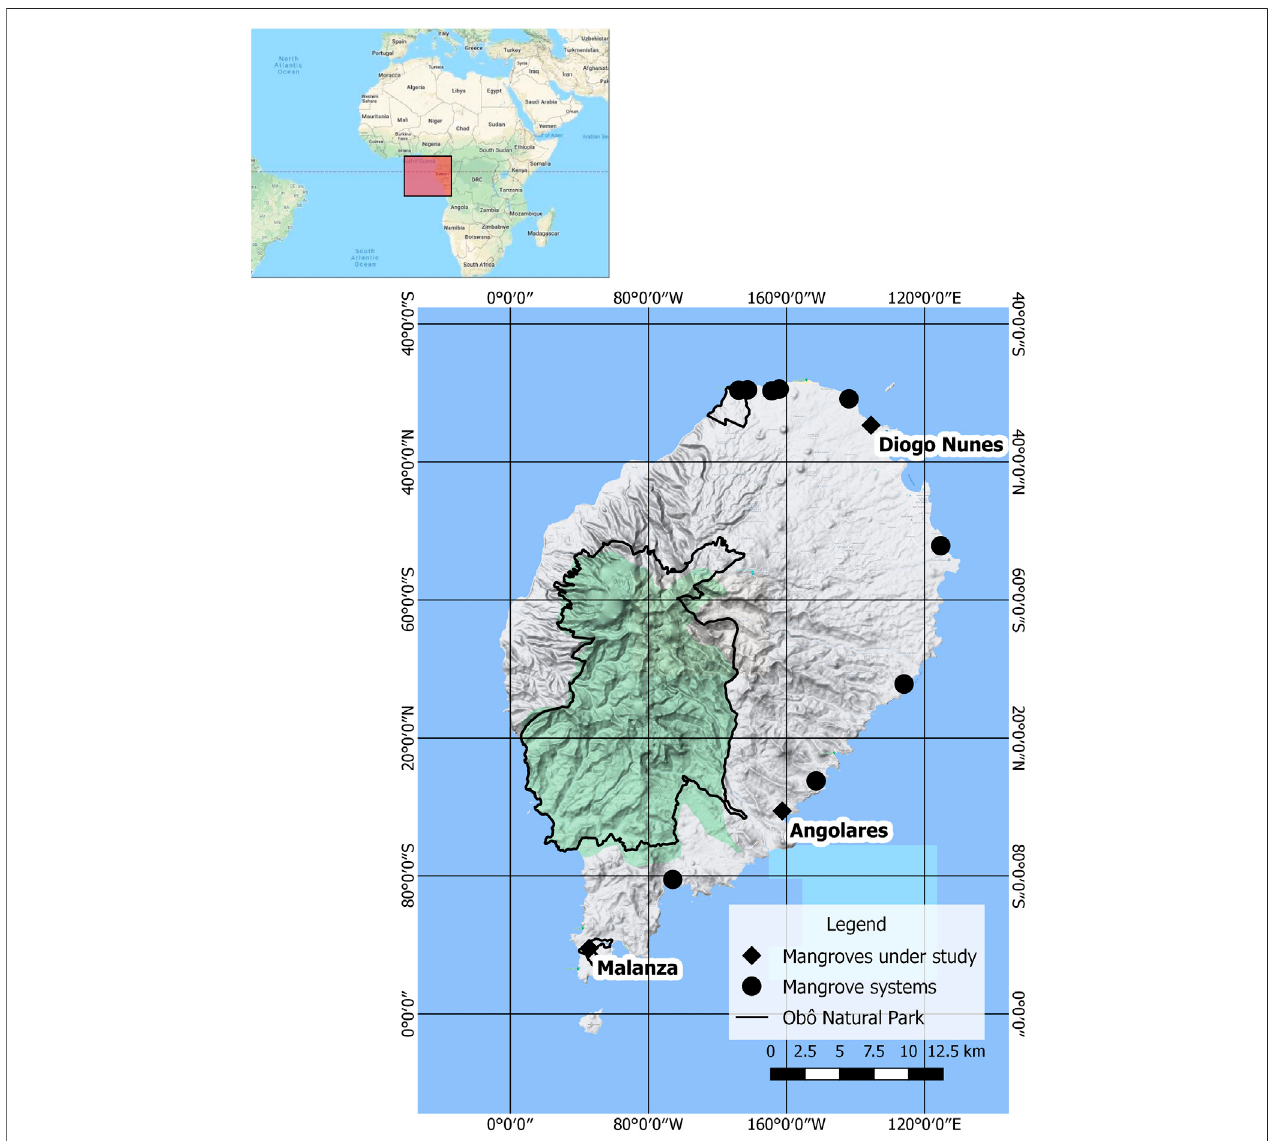
FIGURE 1 | São Tomé island and mangrove systems identi fi ed in the island.